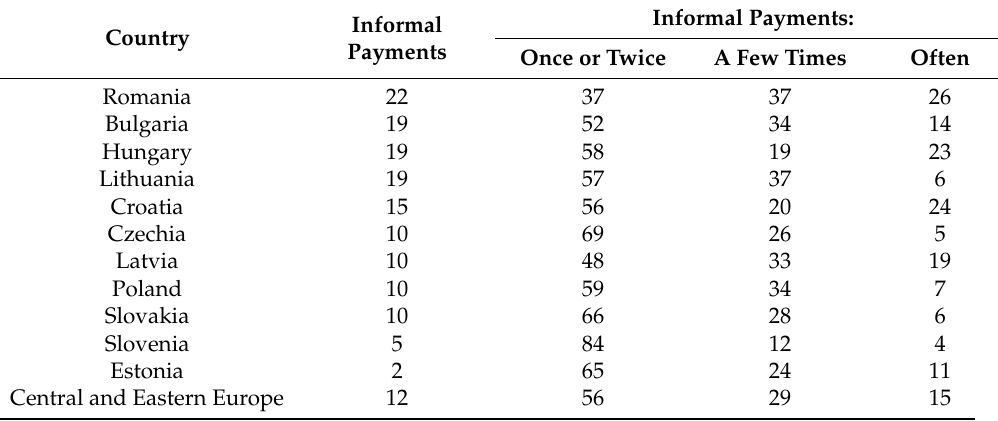
Table 2. Public clinic or hospital users making informal payments, by Central and Eastern European countries ( n = 10,859; %).